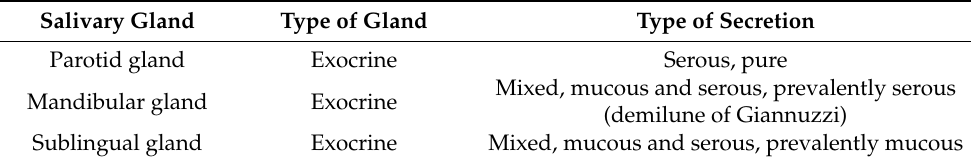
Table 1. Major salivary glands of domestic animals. Type of gland and secretion.